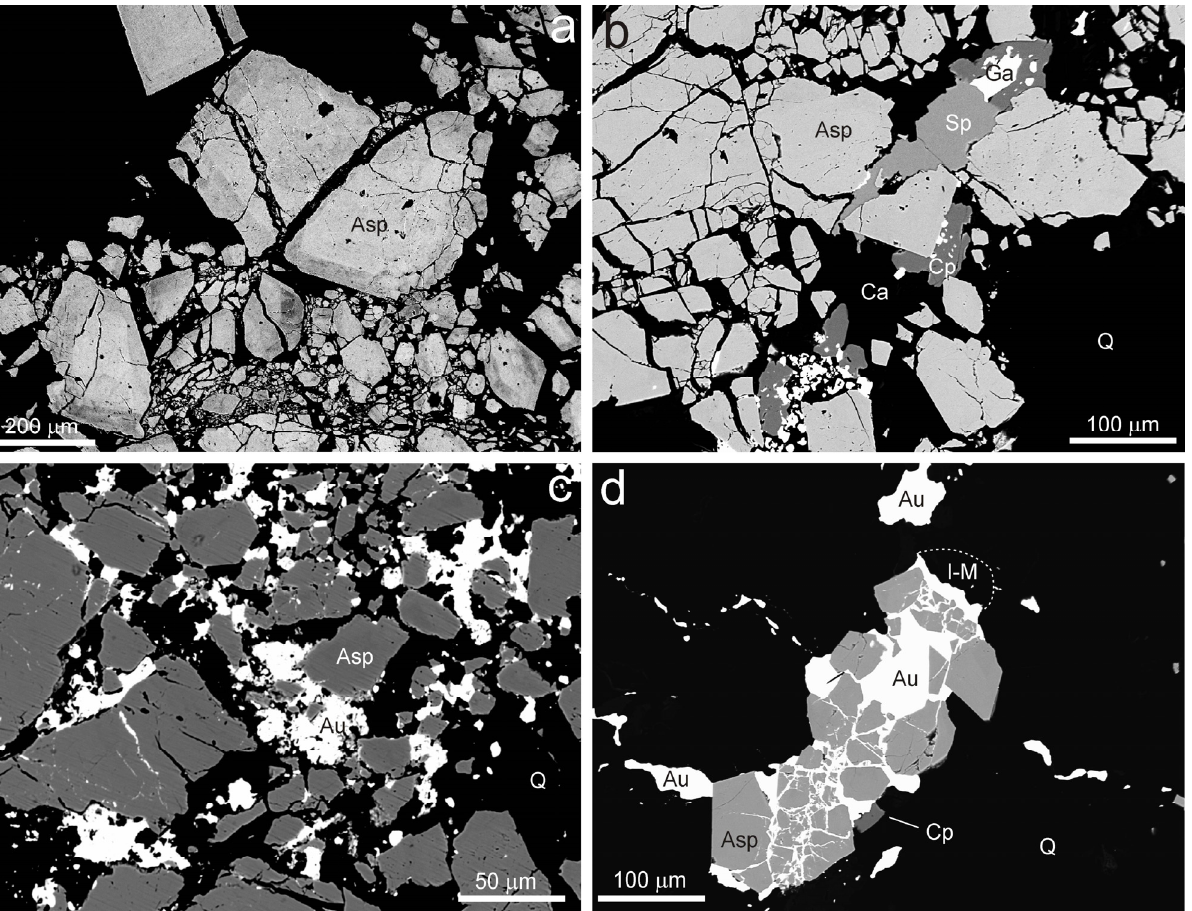
Figure 6. Textures of arsenopyrite-rich portions of the studied Au-bearing vein in BSE images: ( a ) Compositional zoning of fractured arsenopyrite (Asp). ( b ) Arsenopyrite (Asp) hosted by calcite (Ca) and quartz (Q) gangue cut by younger ore veinlet composed of sphalerite (Sp), galena (Ga), and chalcopyrite (Cp). ( c ) Crushed arsenopyrite (Asp) cemented by quartz (Q) with abundant gold (Au) grains. ( d ) Crushed arsenopyrite (Asp) cemented by gold (Au) only. Note the gold veinlet continu-